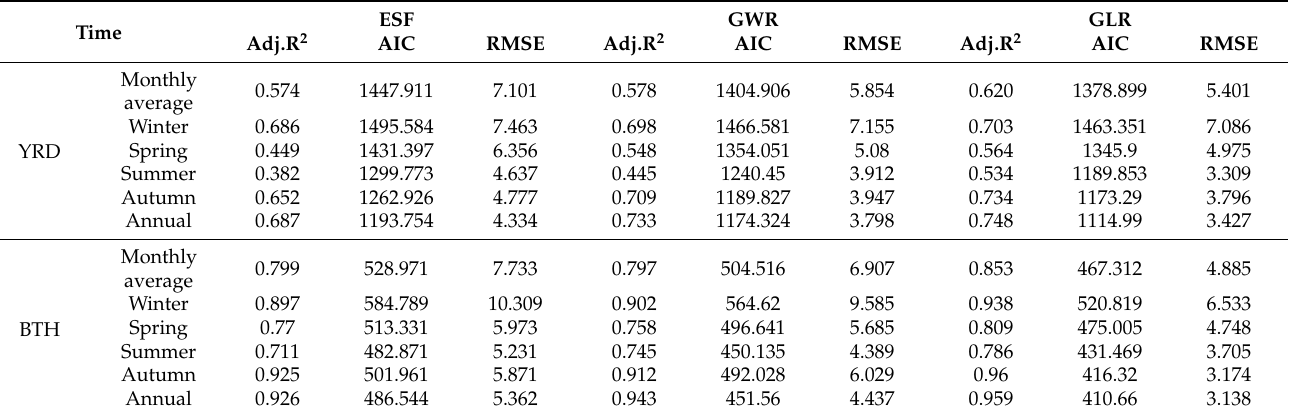
Table 3. Model performance of the ESF, GWR and, GLR models in both regions at monthly, seasonal, and annual time